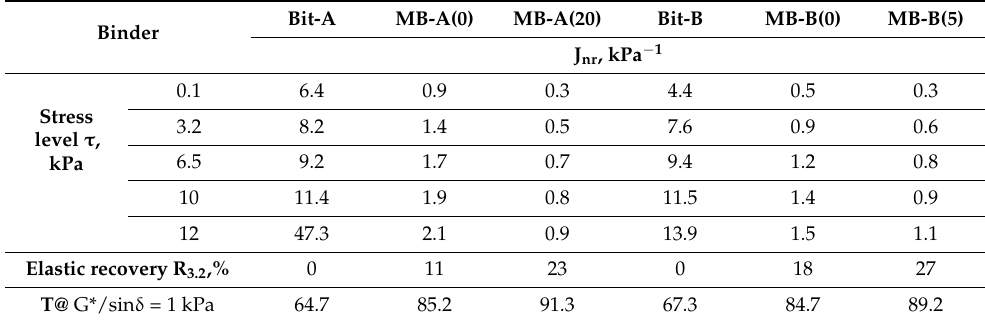
Table 4. The data on unrecoverable creep compliance (J nr ) under different stress levels and